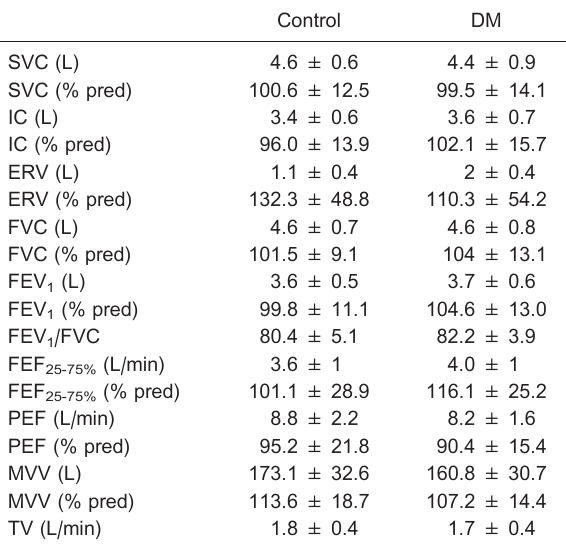
Table 3. Pulmonary function test